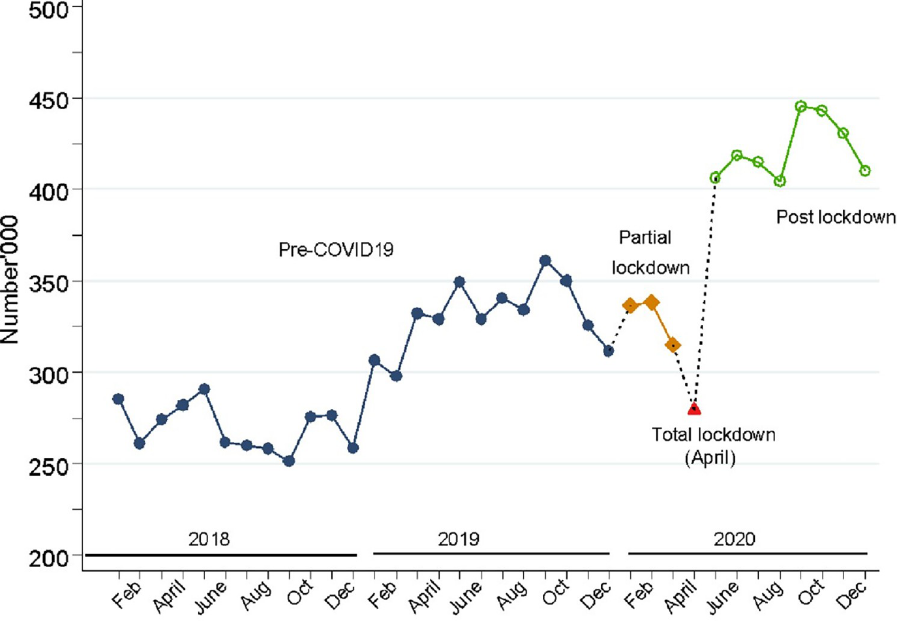
Fig 1. Trends in monthly total number of FP service visits in Uganda, from 2018 to 2020.